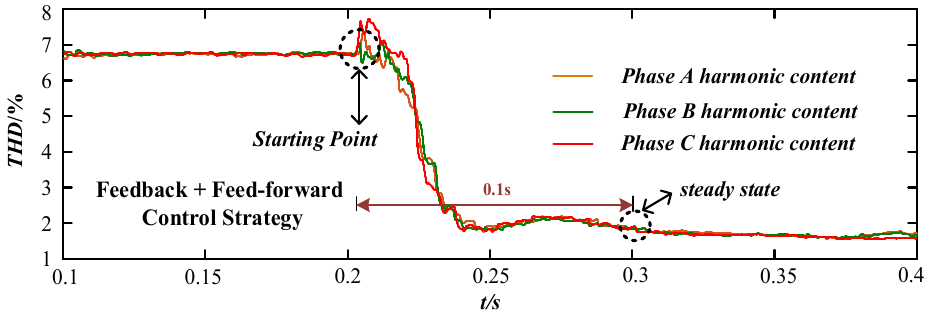
Figure 10. The harmonic change under the compound control strategy of feedback + feed-forward.